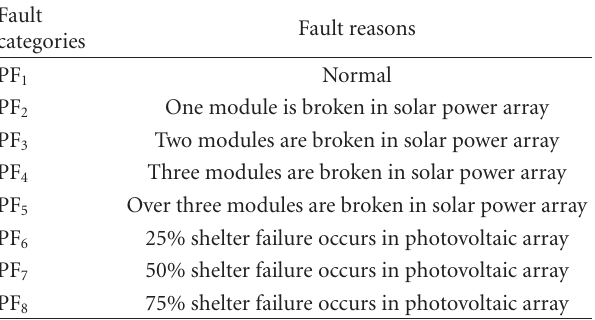
Table 2: Fault categories of photovoltaic array.